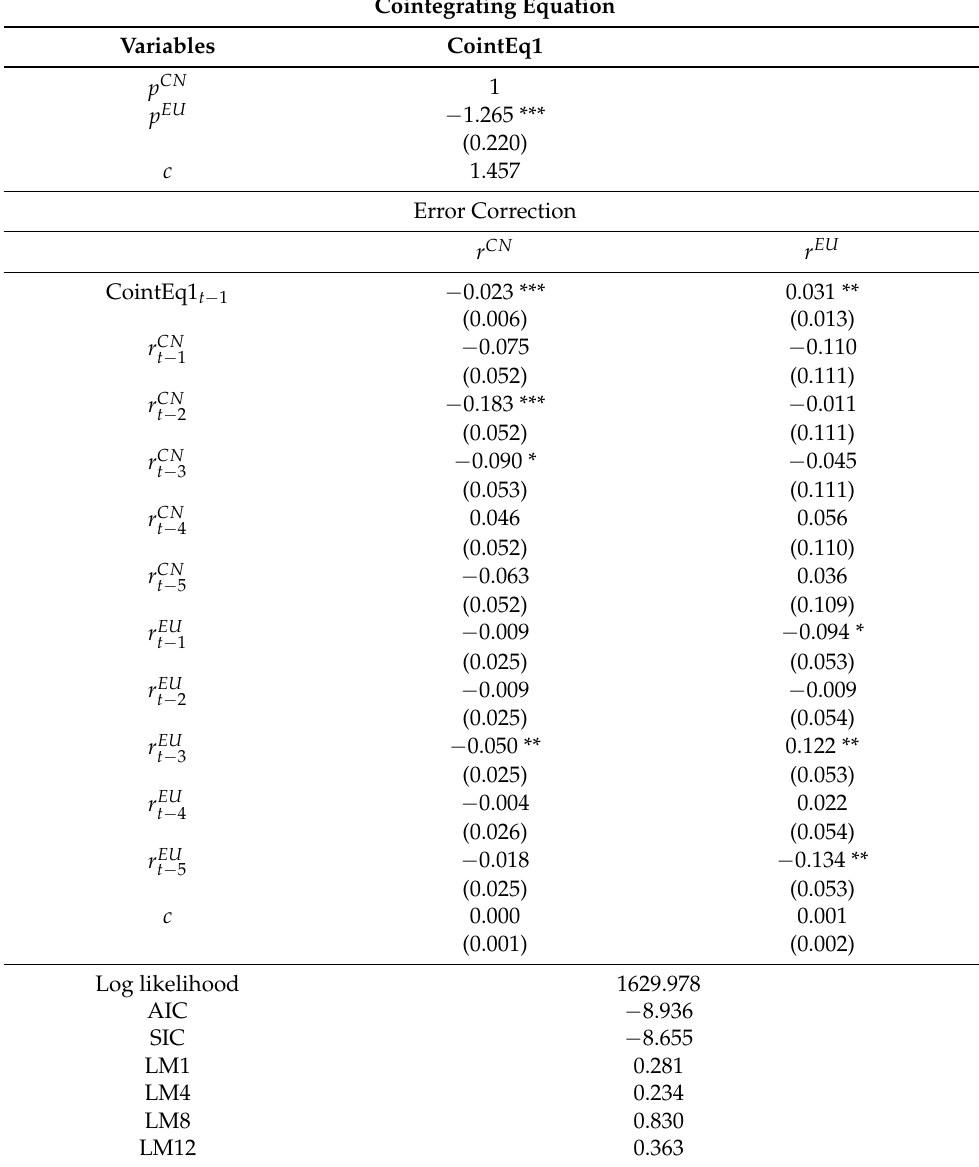
Table 4. VECM estimation